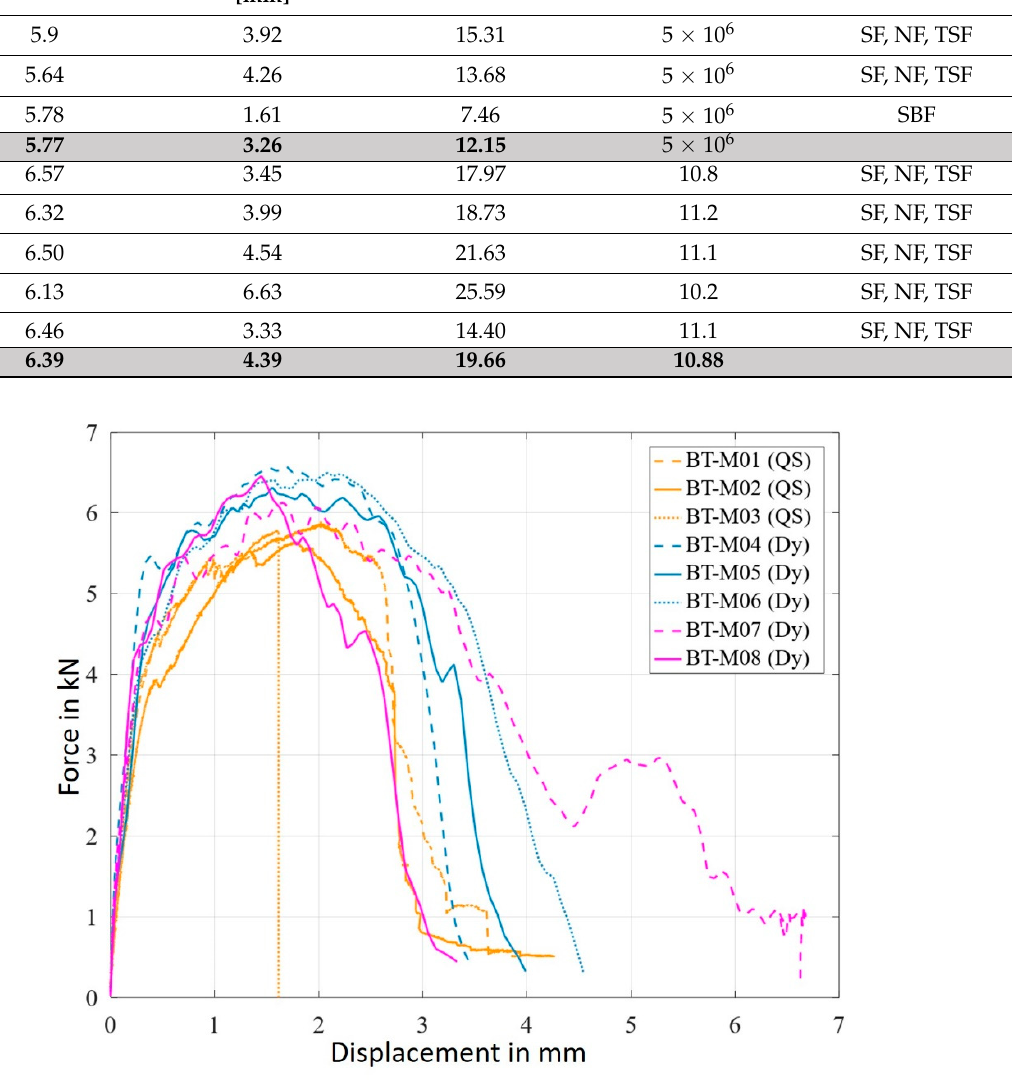
Figure 9. Force–displacement curves of the multi-material bolted joints (QS—quasi-static and Dy— high-rate).